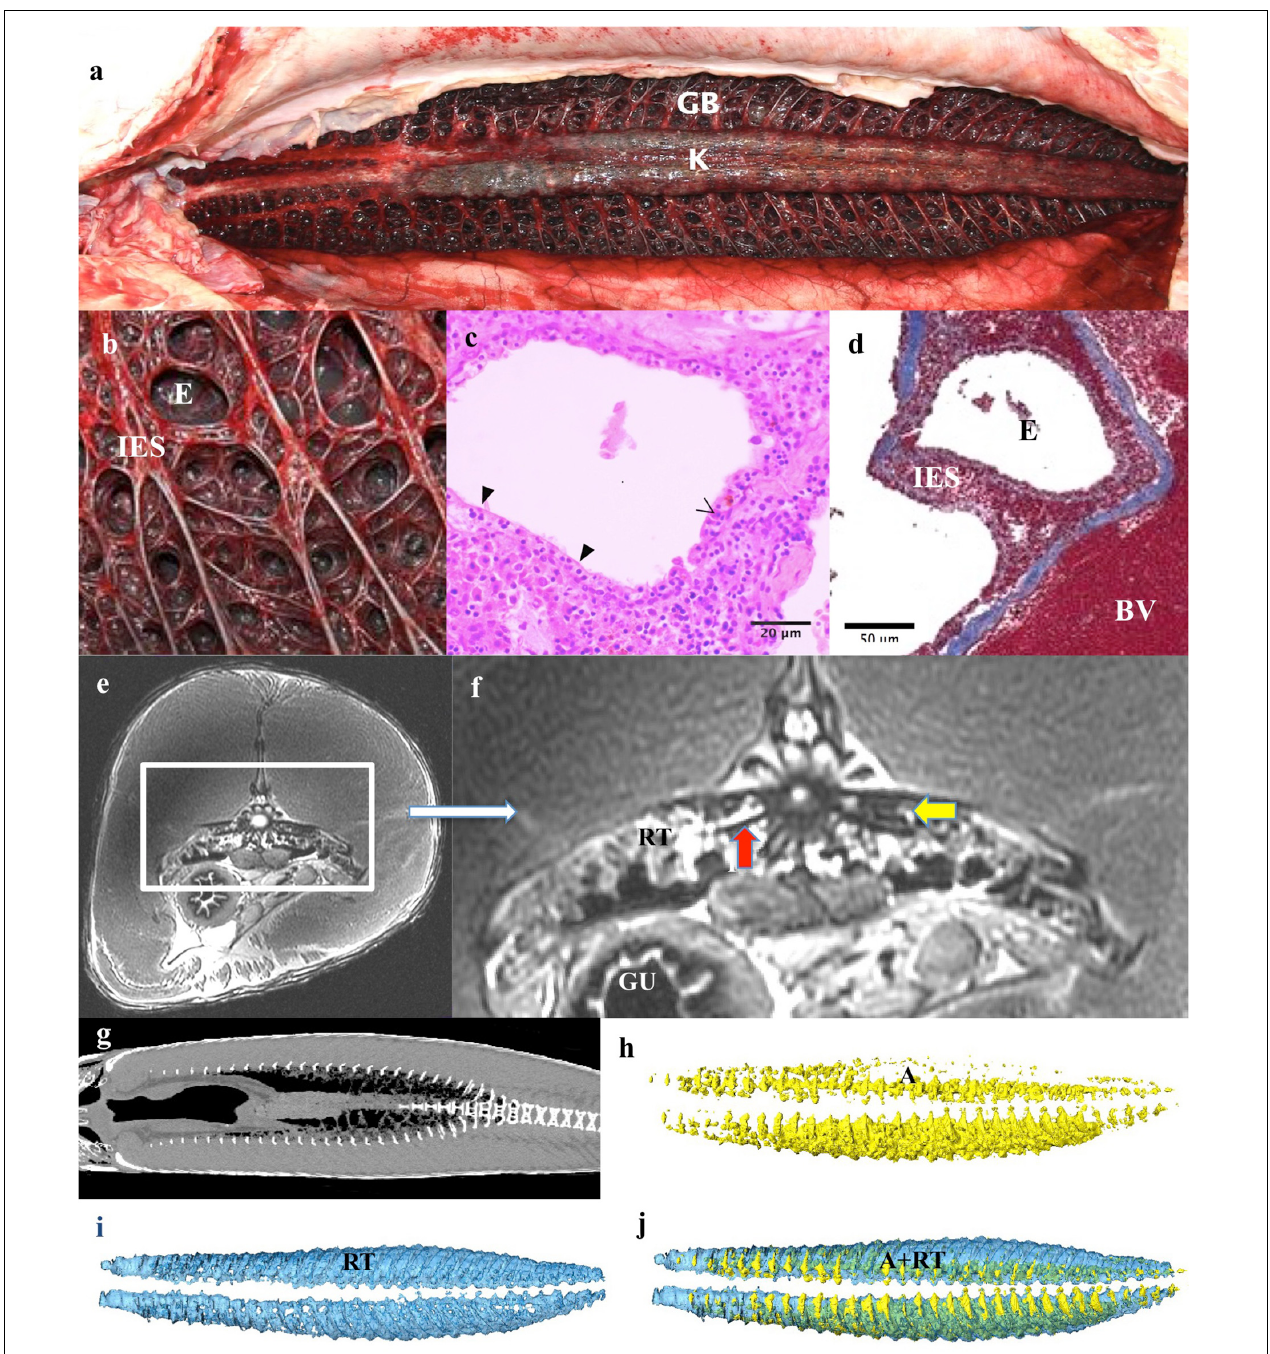
FIGURE 4 | Respiratory system: Respiratory gas bladder. (a) The gas bladder (GB) and respiratory tissue (RT) runs the length of the dorsal coelomic cavity and encompasses the kidneys (K). (b) The dorsal surface is covered by a mat of highly vascular tissue comprising of ediculae and inter-edicular septa. The inter-edicular septa are created by trabeculae made of smooth muscle and connective tissue. The interior surfaces of the gas bladder that are in contact with air are all covered with respiratory epithelium consisting of pavement and columnar epithelial cells. (c,d) A light micrograph stained with Masson’s Trichrome showing a blood vessel (BV), inter-edicular septa (IES) and ediculae (E). Collagen is stained blue. (e,f) Axial and zoomed axial MRI of respiratory tissue at level of mid of the GB demonstrating respiratory tissue (RT), gas in air bladder (A), Gas in stomach (G). The kidneys (K) are seen suspended in the GB, vertebrae (V) and gut (GU). Vertebral bodies appear to have spicules emanating from them (red arrow) – Similar appearance seen on CT in Figure 10 . This feature is presumably to increase surface area for gas exchange and have not previously been described in this species. (g) Coronal CT scan at level of GB demonstrating relationships of contents of GB. (h–j) 3D reconstructions from CT data. (h) Air (A) fraction in GB (yellow), (i) Vascular respiratory tissue fraction (blue). (j) Reconstructions of GB showing the relationship of A to RT.